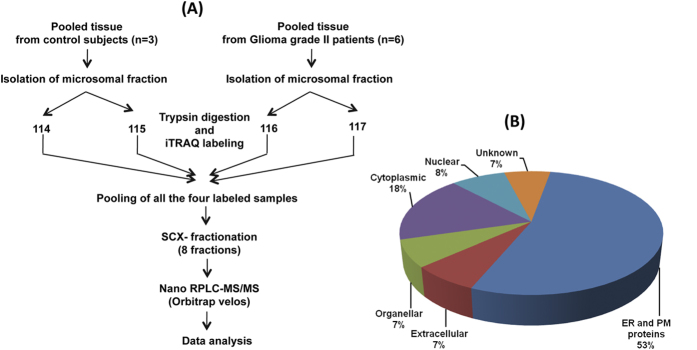
(A) Overall workflow for quantitative proteomic analysis of the tumor samples. Details of preparation of microsomal membrane proteins, iTRAQ labeling, LC-MS/MS analysis and protein identifications are provided under Methods. (B) Subcellular classification of differentially expressed proteins. Subcellular classification of differentially expressed proteins (n = 340) was carried out using Human Protein Reference Database and shows the enrichment of the membrane proteins.